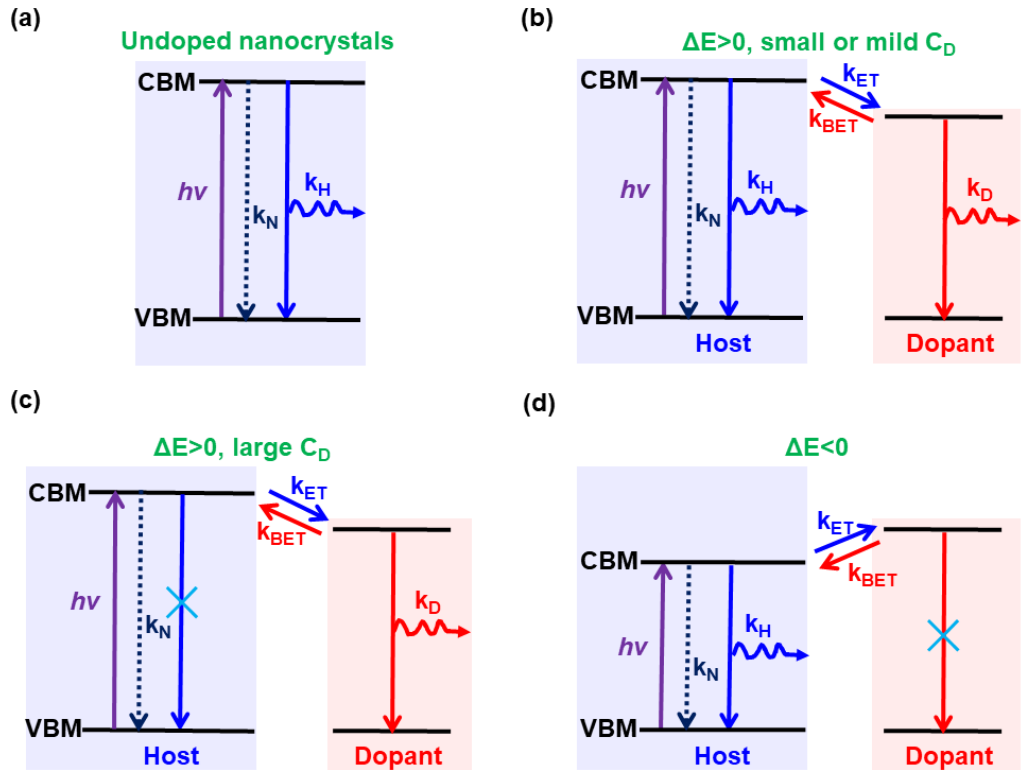
Figure 2. Diagram of photoluminescence (PL) emission mechanisms for undoped and Mn-doped nanocrystals. ( a ) Emission mechanism for undoped nanocrystals. VBM and CBM denote the valance band maximum and conduction band minimum, respectively. Both host and dopant emissions ( b ), only the host emission ( c ), and only the dopant emission ( d ) exist in Mn-doped